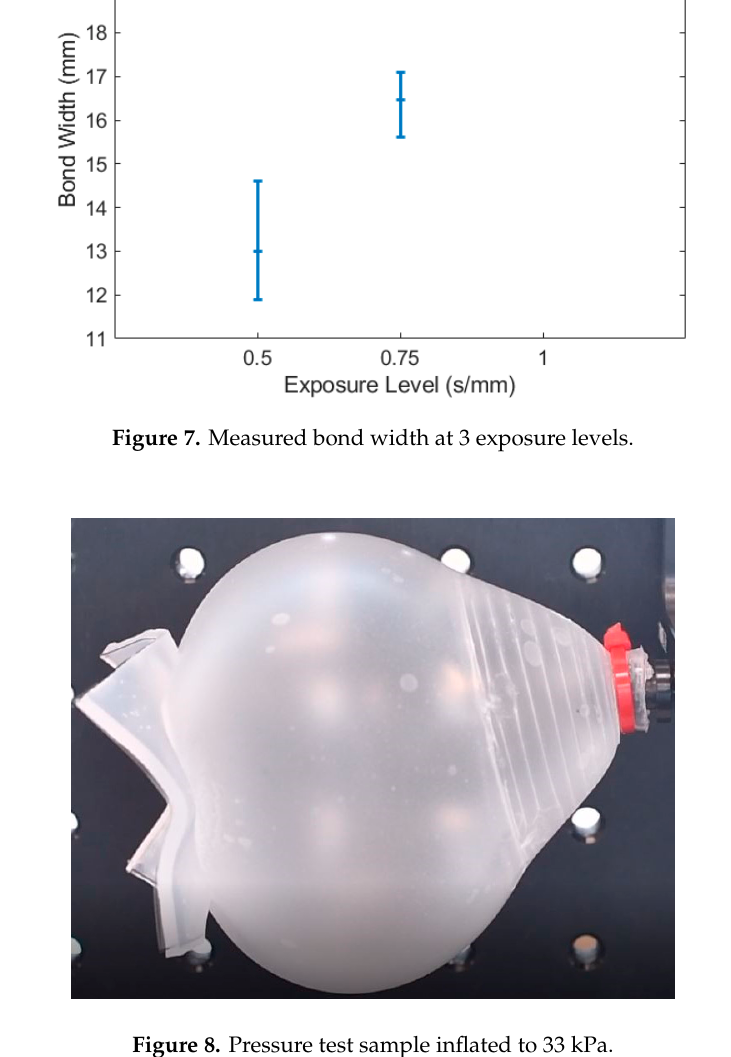
Figure 7. Measured bond width at 3 exposure levels.